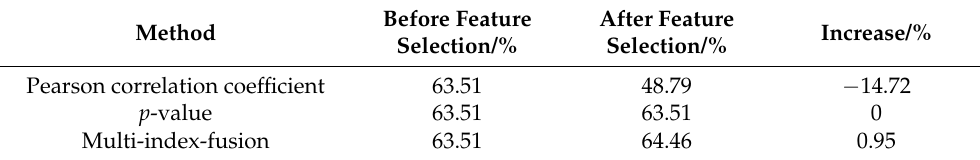
Table 8. Feature selection effects of different feature selection methods.